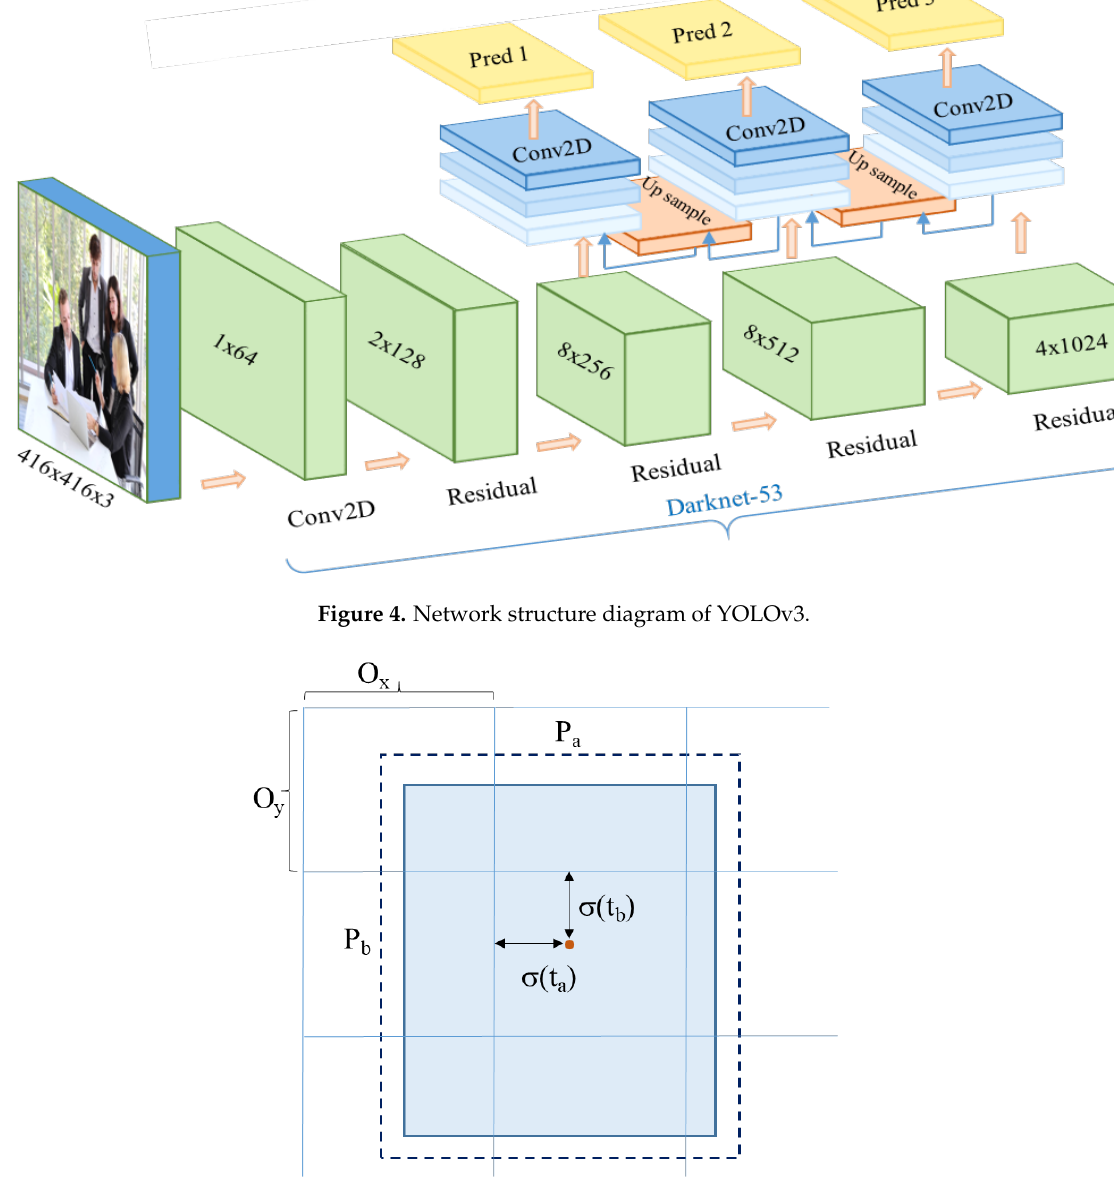
Figure 5. Bounding box with local prediction.